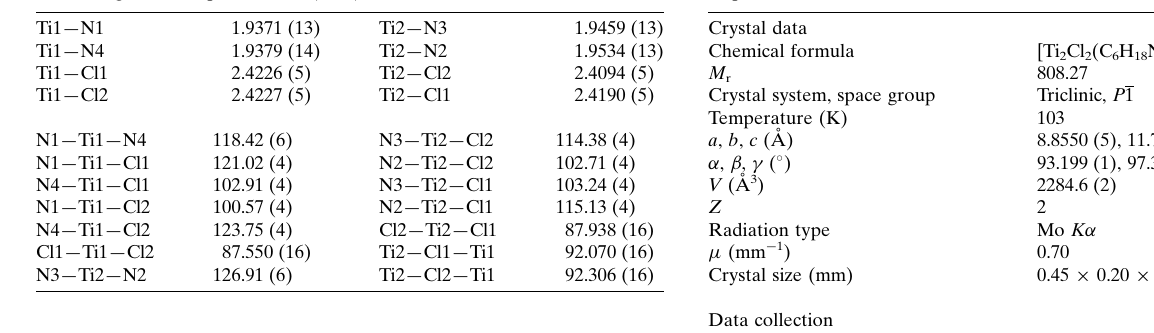
Table 1 Selected geometric parameters (A˚ , (cid:2) ).